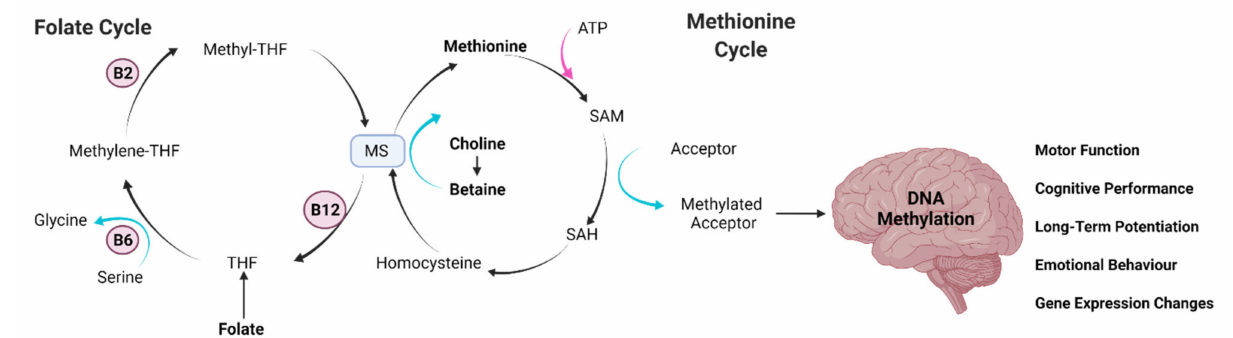
Figure 1. Key dietary molecules that modulate DNA methylation and their link to cognitive changes. The overview shows the interplay between the folate cycle and the methionine cycle, which produce S-adenosyl methionine (SAM) in order to methylate DNA within the brain. Brain DNA methylation has led to cognitive and genetic changes that ultimately could drive to neurodegenerative processes. Abbreviations: adenosine triphosphate, ATP; methionine synthase, MS; S-adenosyl homocysteine, SAH; tetrahydrafolic acid,